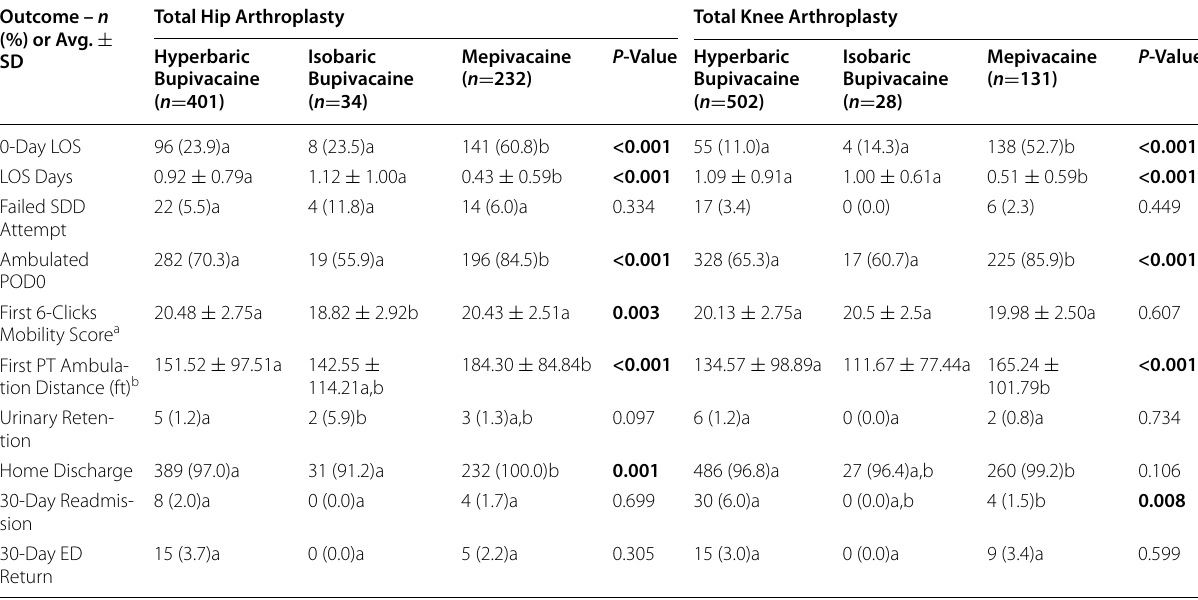
P -Values <0.05 in bold Subscript letters denote post hoc groups that do not differ from each other at P <0.05, continuous values are Bonferroni adjusted. LOS length of stay, SDD same day discharge, POD postoperative day, PT physical therapy, ED emergency department a n THA 367 HB, 33 IB, 188 M; TKA 502 HB, 28 IB, 262 M = b n 362 HB, 33 IB, 179 M; TKA 467 HB, 27 IB, 191 M =